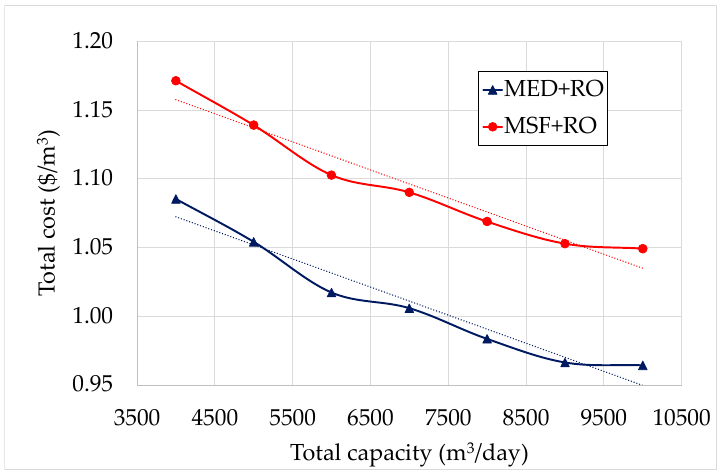
Figure 5. Total cost of produced water versus the total capacity (degree of hybridization = 35%).